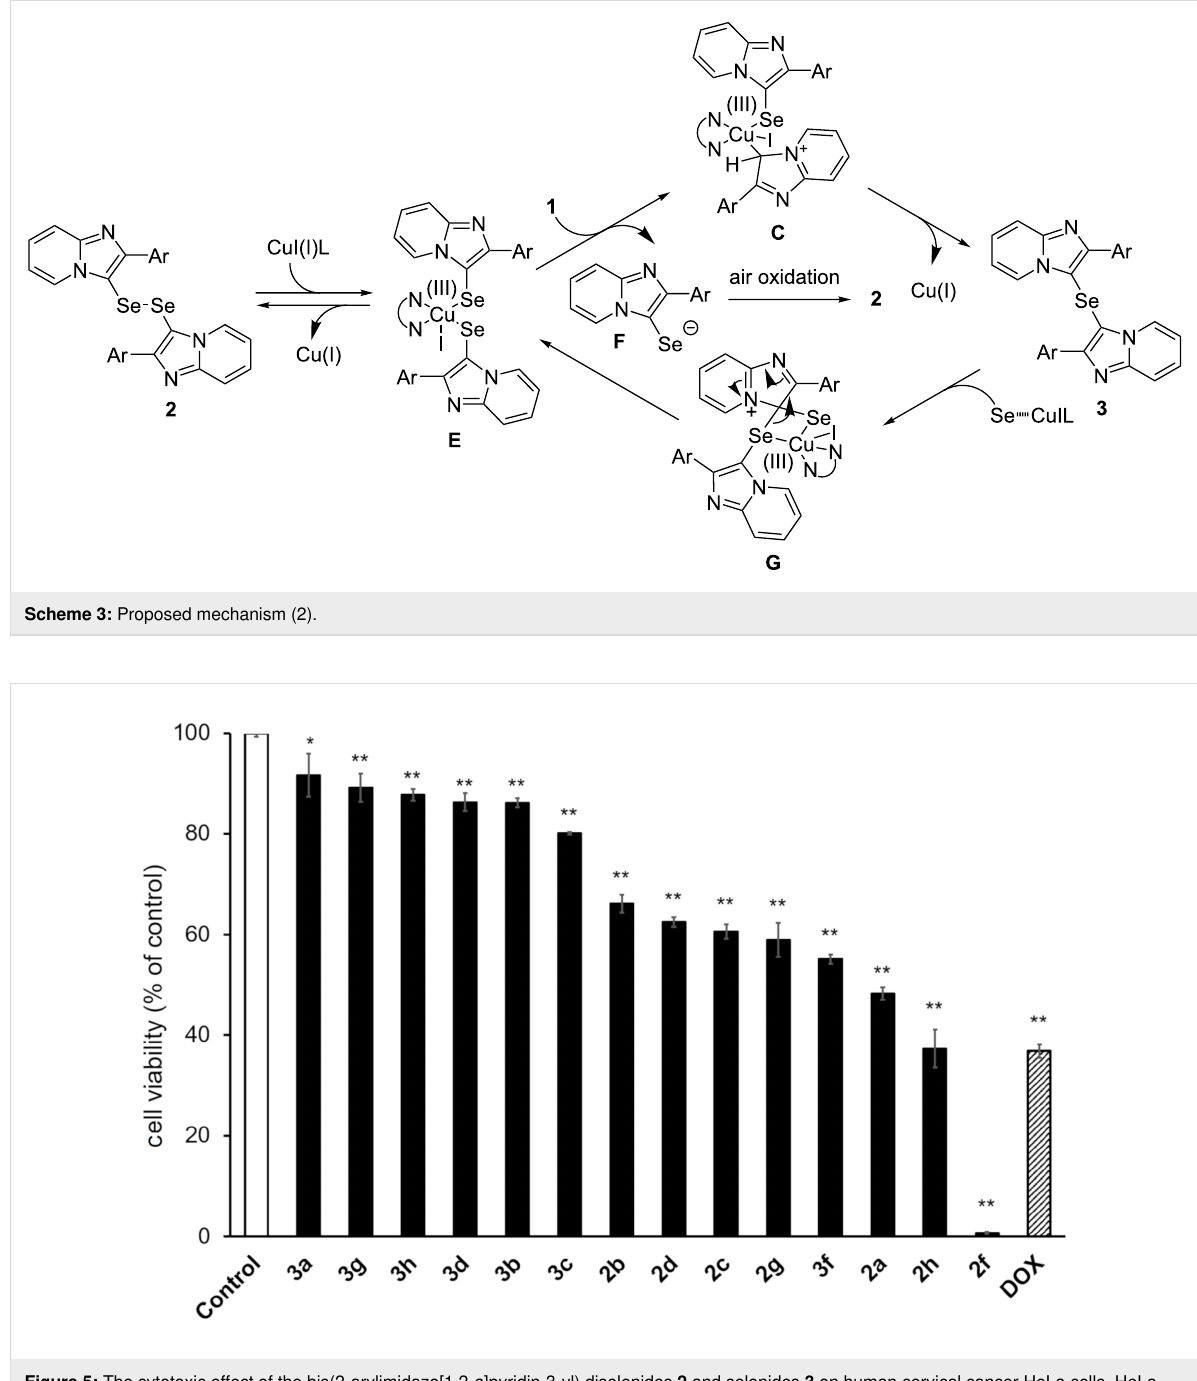
more cytotoxic toward HeLa cancer cells than to human brain microvascular endothelial (HBME) cells, which are noncancerous (Figure 7). Hence, the diselenide 2f may possibly be highly cytotoxic toward various cancer cell lines and rela- tively low cytotoxic against noncancer